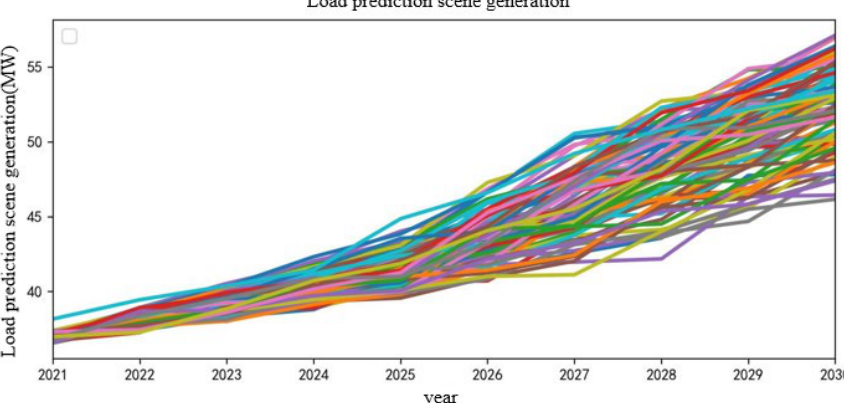
Figure 11. Final load prediction results.